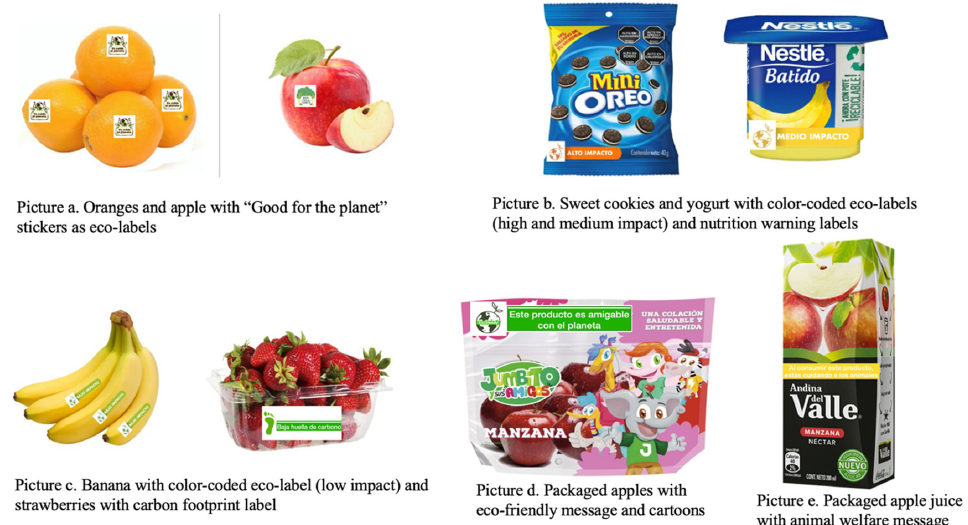
F igure 2. Food products with sustainability labels designed by the